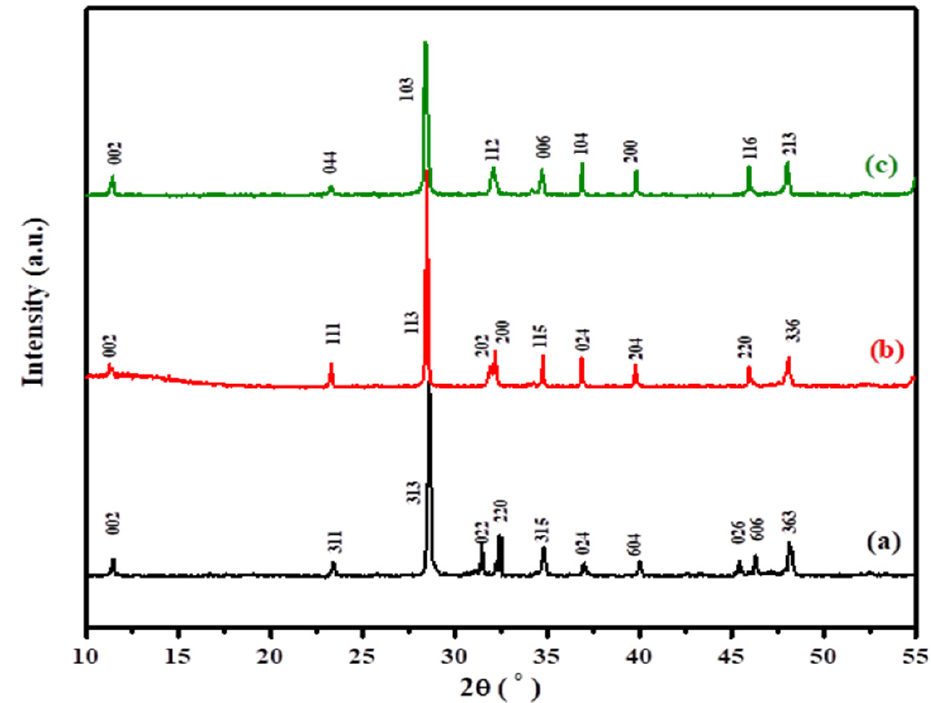
Figure 1. XRD patterns of the as–prepared BiFeVOx.y systems for ( a ) y = 0.03, ( b ) y = 0.07, and ( c ) y = 0.15.